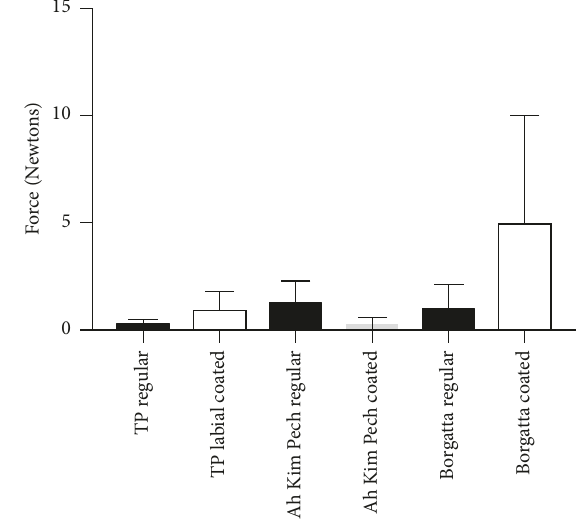
Figure 9: Comparison of the mean force (N) of the permanent deflection between the rectangular 0.016 󸀠󸀠 × 0.025 󸀠󸀠 regular and coated Ni-Ti wires. There was no statistically significant difference between the coated and regular Ni-Ti wires from TP and Ah Kim Pech; however, for the coated Borgatta wire, there was a significant increase in the permanent deflection ( 𝑝 < 0.01